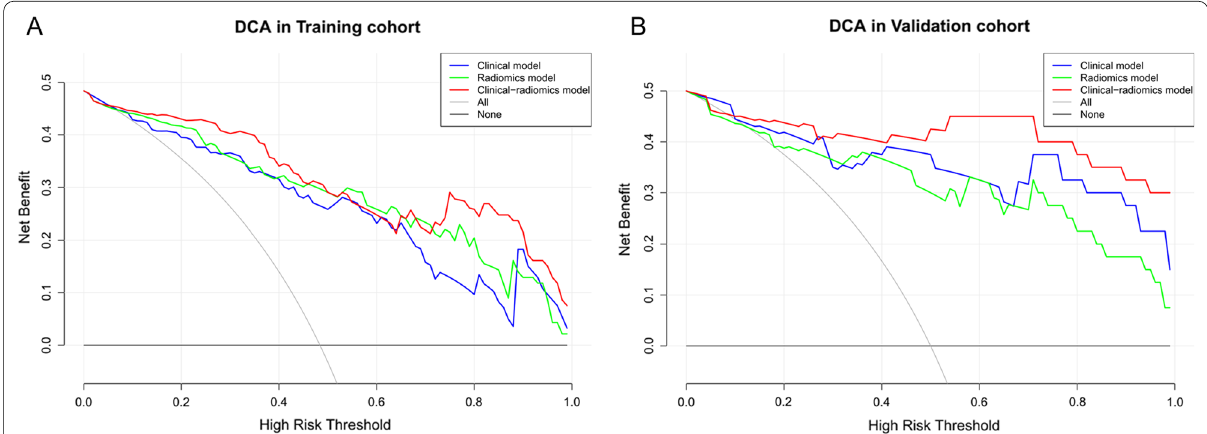
Fig. 7 A Decision curve analysis (DCA) for the clinical model, radiomics model and nomogram in the training set. B DCA for the clinical model, radiomics model and nomogram in the test